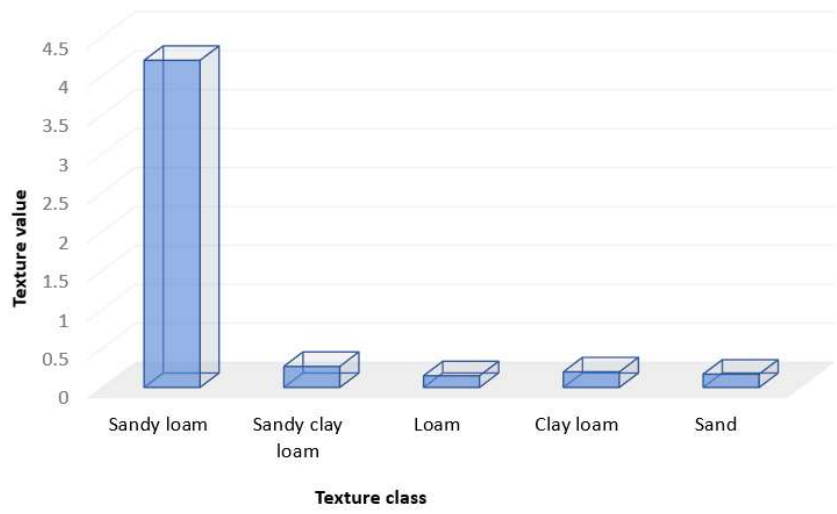
Figure 6. The distribution of soil texture in Koromi catchment of Jos East LGA.